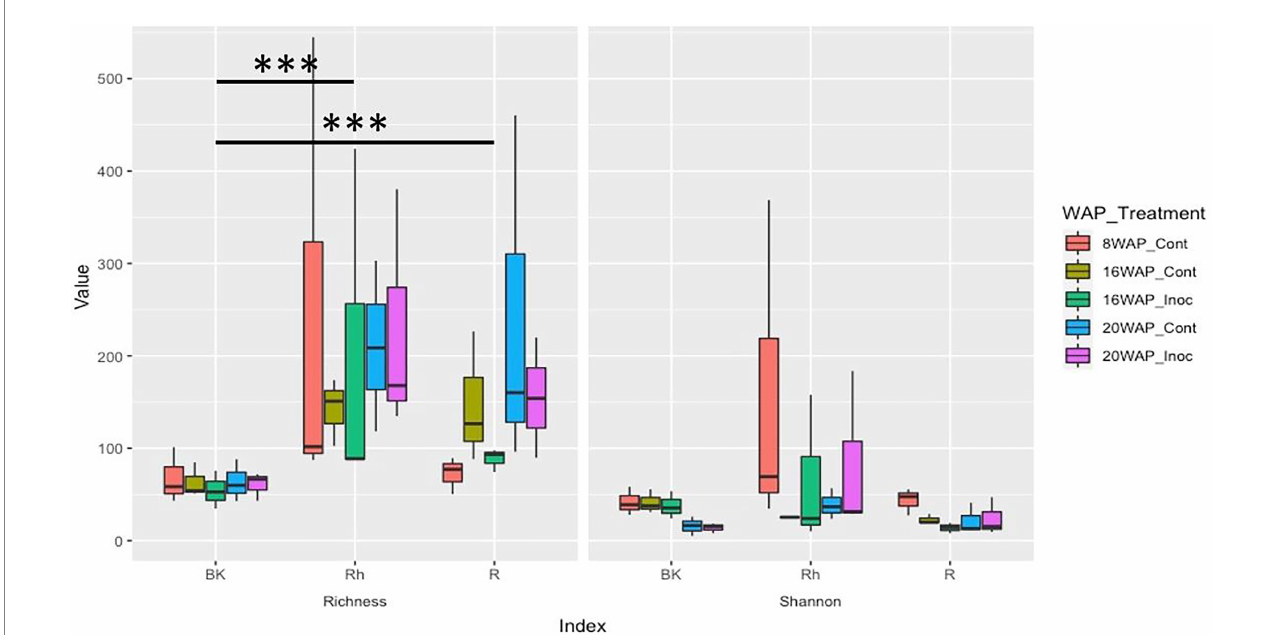
FIGURE 2 Alpha-diversity indices of the 16S rRNA gene sequences as determined by the species richness (Left) and Shannon indices (Right) based on the effective number of species using coverage-based rarefaction at a rate of coverage of 98.5% corresponding to the lower range in the iNext package of the R software. Cont, control non-inoculated treatment; Inoc, inoculation treatment; WAP, weeks after planting; R, root; Rh, rhizosphere; BK, bulk soil.